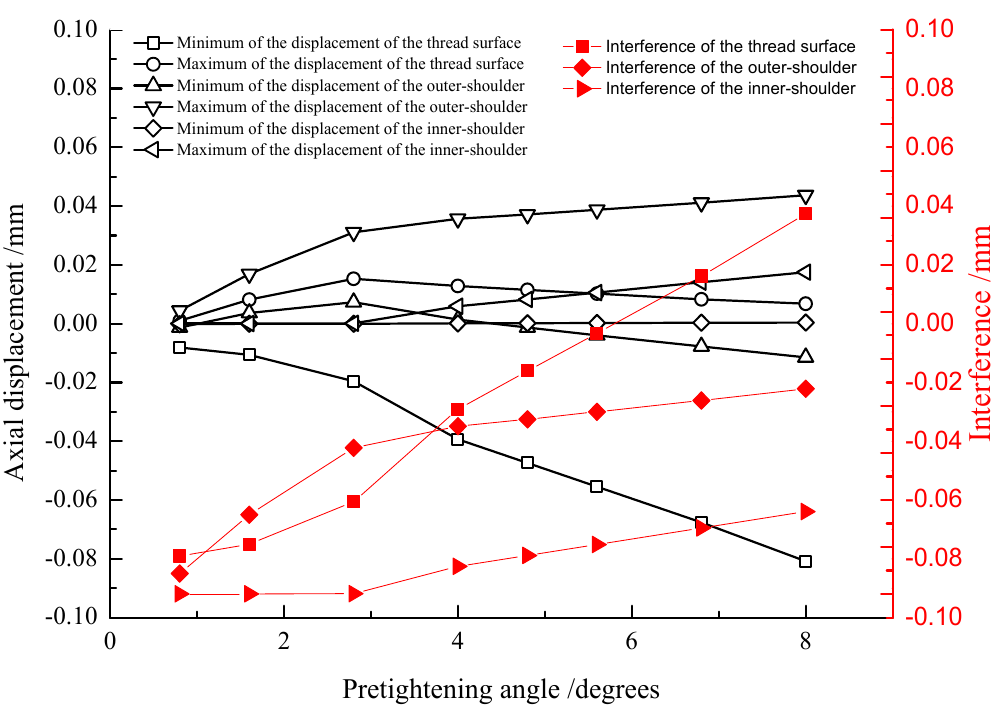
Figure 15. Relationship between the displacement and interference of each surface with respect to the pretightening angle.